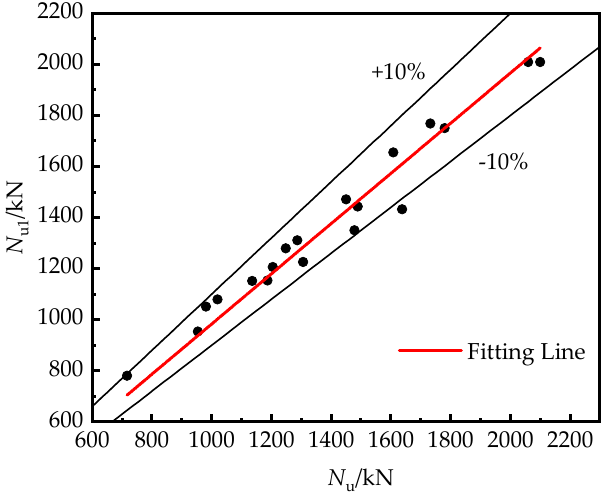
Figure 12. Fitting relationship between experimental ( N u ) and calculation ( N u1 ) results.